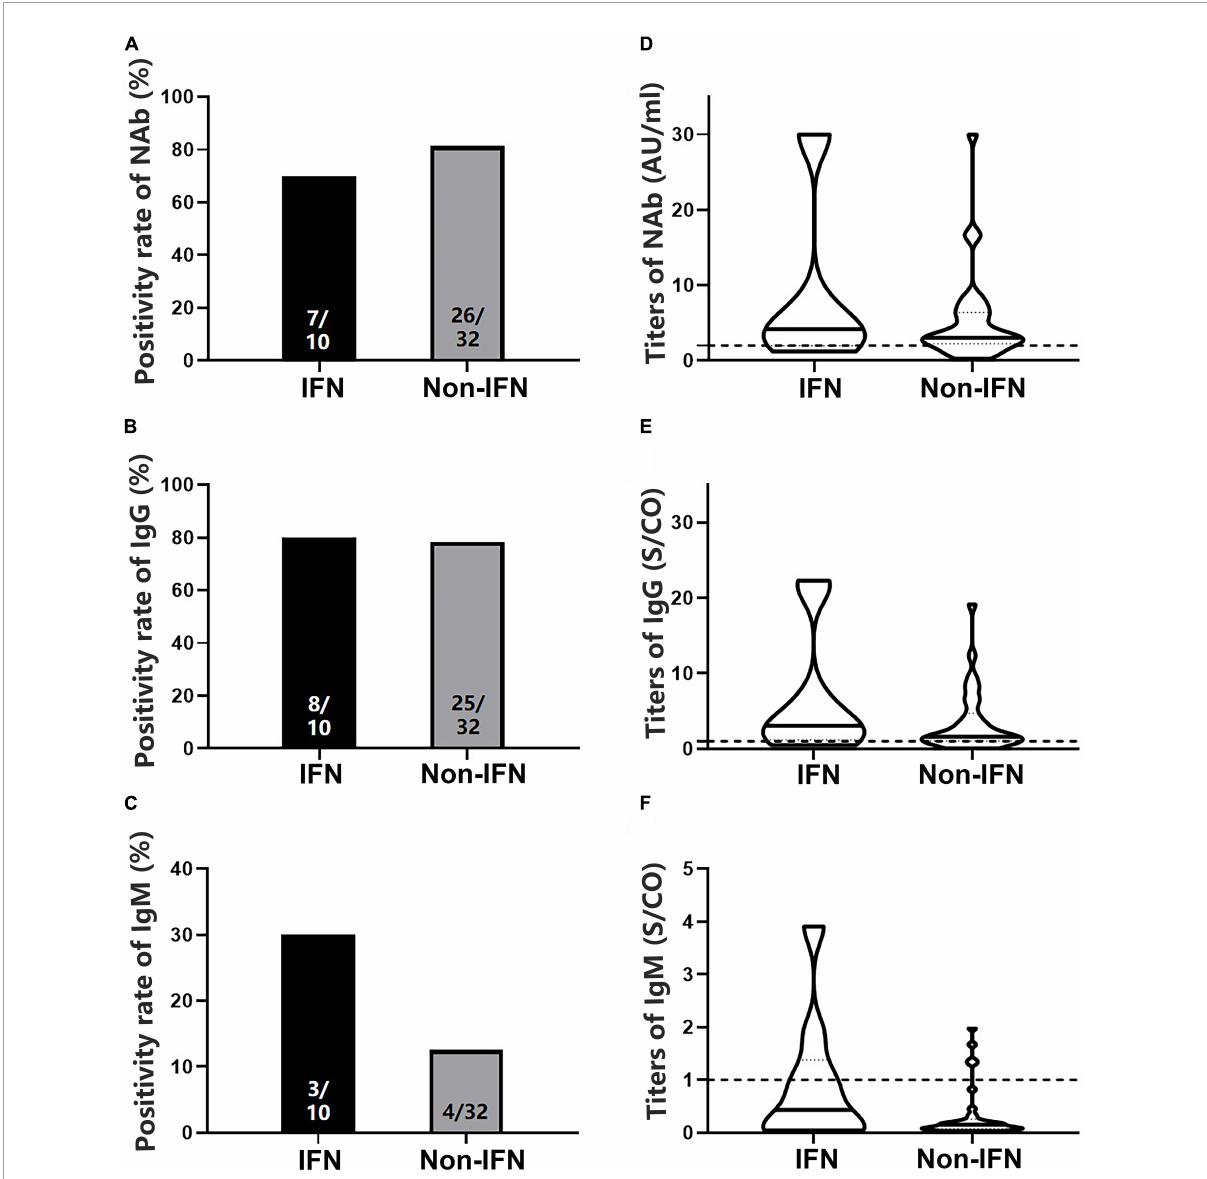
FIGURE3 Comparison of the positivity rates and titers of antibodies against severe acute respiratory syndrome coronavirus 2 (SARS-CoV-2) between the interferon (IFN) and non-IFN groups among patients with CHB. (A–C) Comparison of NAb, immunoglobulin G (IgG), and immunoglobulin M (IgM) positivity rates between the IFN and non-IFN groups. (D–F) Comparison of NAb, IgG, and IgM antibody titers between the IFN and non-IFN groups. The IFN group, patients with CHB receiving nucleos(t)ide analogs (NAs) combined with Peg-interferon-alpha therapy; the non-IFN group, patients with CHB receiving NAs monotherapy; n1/n2 in bars, positive cases/all cases; dotted line, cut-off value; CHB, chronic hepatitis B; NAb, neutralizing